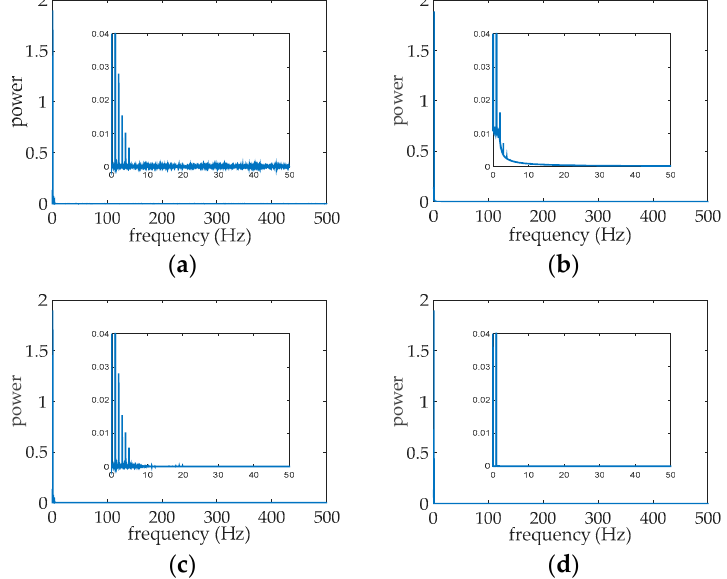
Figure 6. Spectrums of y s in simulation ( a ) before the filter; ( b ) after the Butterworth filter; ( c ) after the DWT based filter and ( d ) after the designed